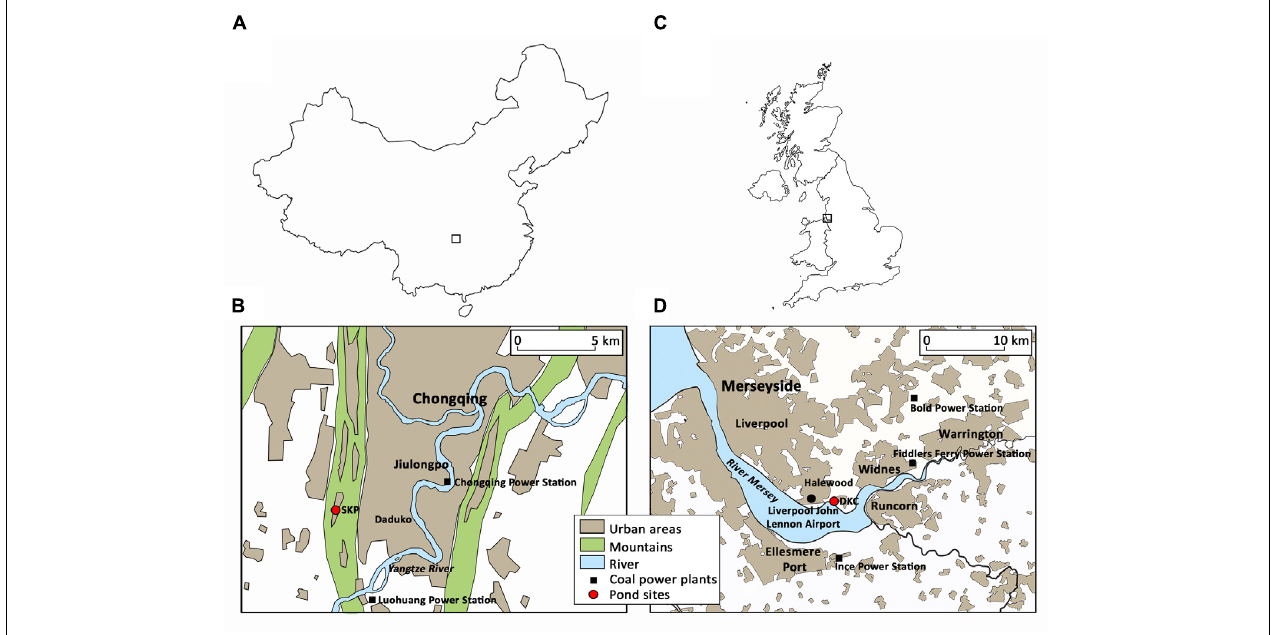
FIGURE 1 | Location of Sky Pond (SKP) in Chongqing (B) , southwest China (A) and Dogs Kennel Clump Pond (DKC) in the Merseyside region (D) , northwest England, United Kingdom (C) .